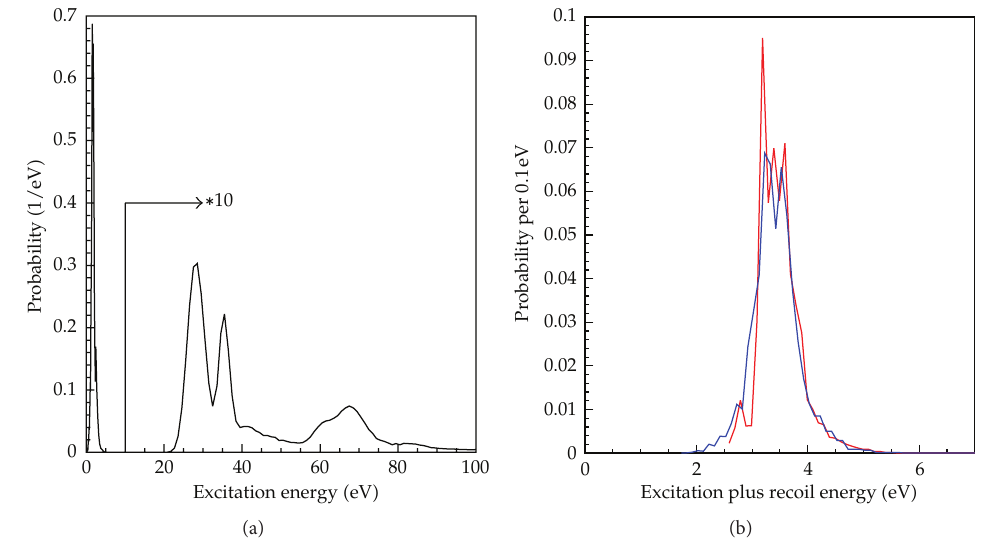
+ Figure 5: Excitation spectrum of the daughter ( 3 HeT ) in 𝛽 -decay of molecular tritium (a) and rotational-vibrational excitations of the ( 3 HeT ) + molecular ion only (right, red solid curve). In comparison, the rotational-vibrational excitations of the ( 3 HeH ) + molecular ion from HT 𝛽 -decay are shown ((b), blue line) [34]. Please note, that the abscissa of the right plot reads excitation energy plus maximum recoil energy according to